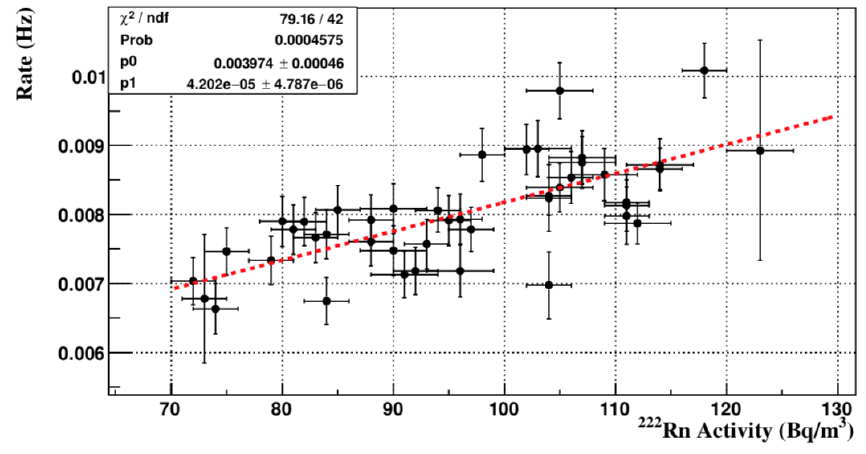
Figure 17. Daily Radon activity vs. Background rate in NEXT-White [17].